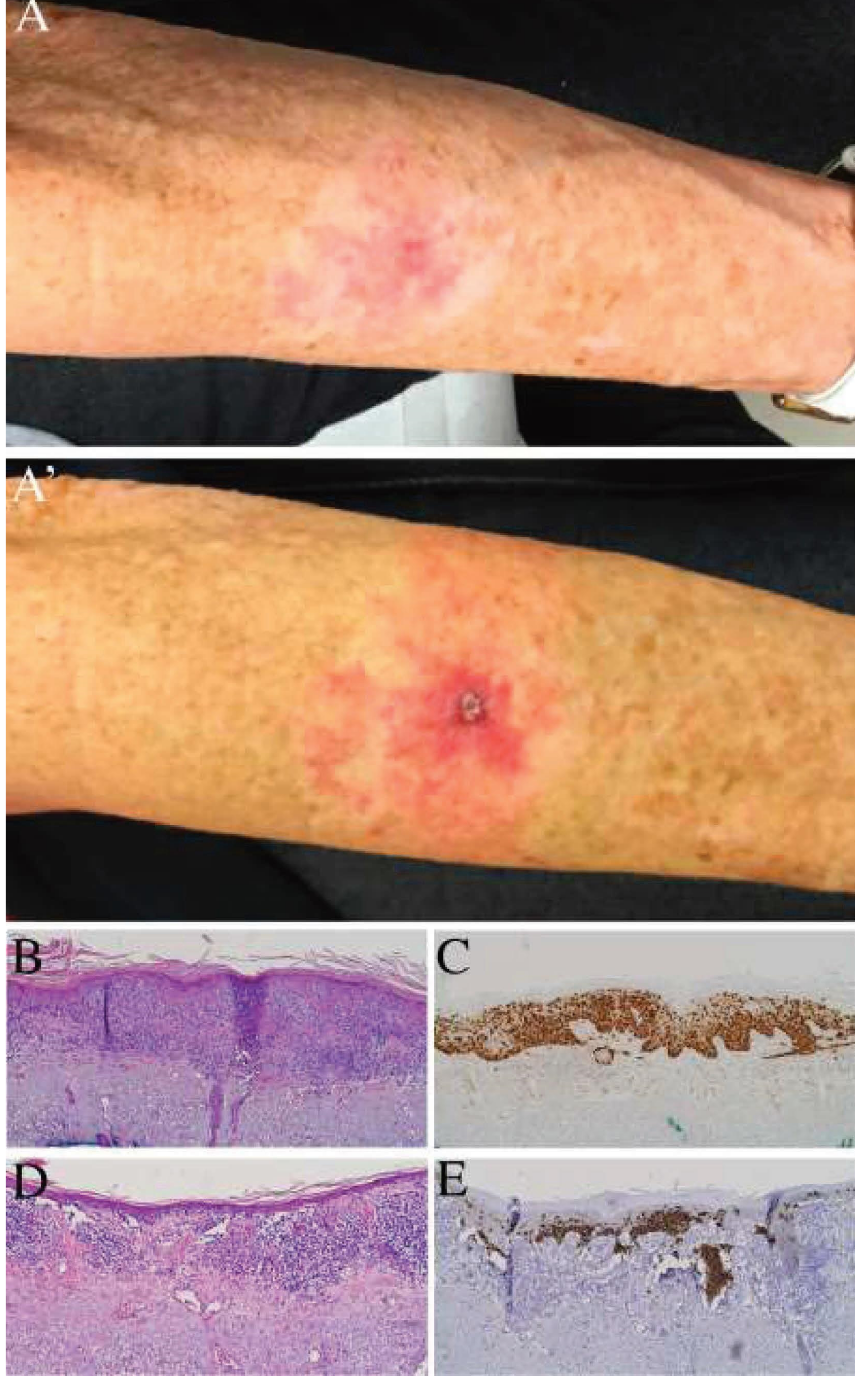
Figure 1: (a) A 5cm ovoid, pink-white, minimally scaly, thin plaque on the arm of a 69-year-old female, Fitzpatrick skin type II. (a ′ ) Postbiopsy. (b) H&E and (c) Melan-A immunohistochemistry revealing melanoma in situ, lentigo maligna type, on shave biopsy. (d) H&E and (e) Melan-A immunohistochemistry revealing invasive lentigo maligna melanoma, Breslow depth 0.3 mm. All microscopy is performed at 100x total